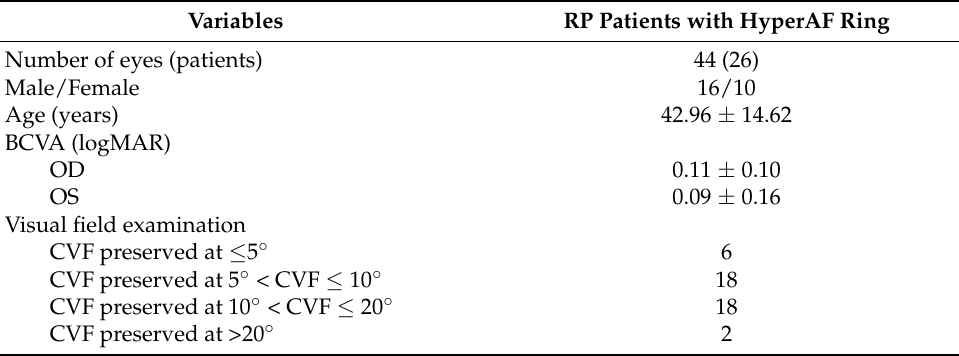
Table 1. Demographics and clinical characteristics of the study participants. Variables RP Patients with HyperAF Ring Number of eyes (patients) 44